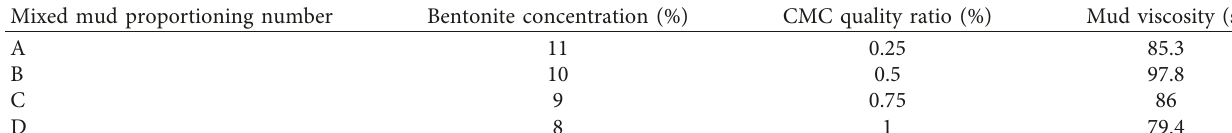
Table 4: Sodium bentonite-CMC mixed mud mixing ratio grouping. Mixed mud proportioning number Bentonite concentration (%)